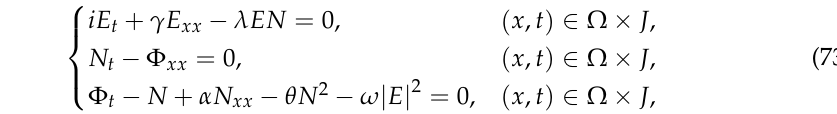
Table 2. Space-time convergence results for Example 1 with τ = 1